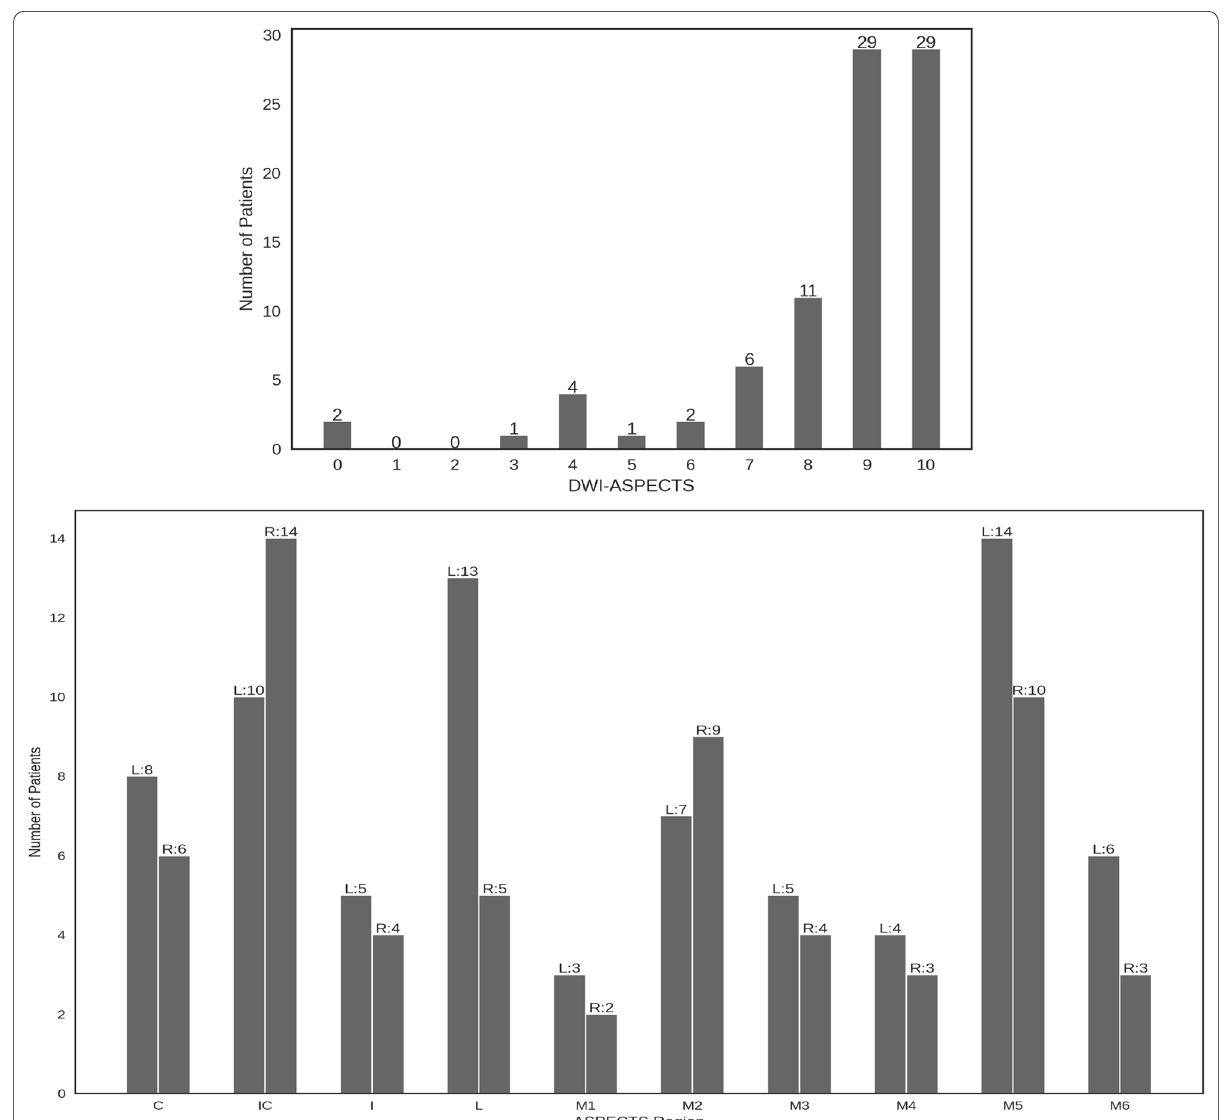
Fig. 3 DWI-ASPECTS and the ASPECTS-Region distribution of the external validation set. C, Caudate; IC, Internal capsule; I, Insula; L, Lentiform; M1, frontal operculum; M2, anterior temporal lobe; M3, posterior temporal lobe; M4, anterior MCA; M5, lateral MCA; M6, posterior